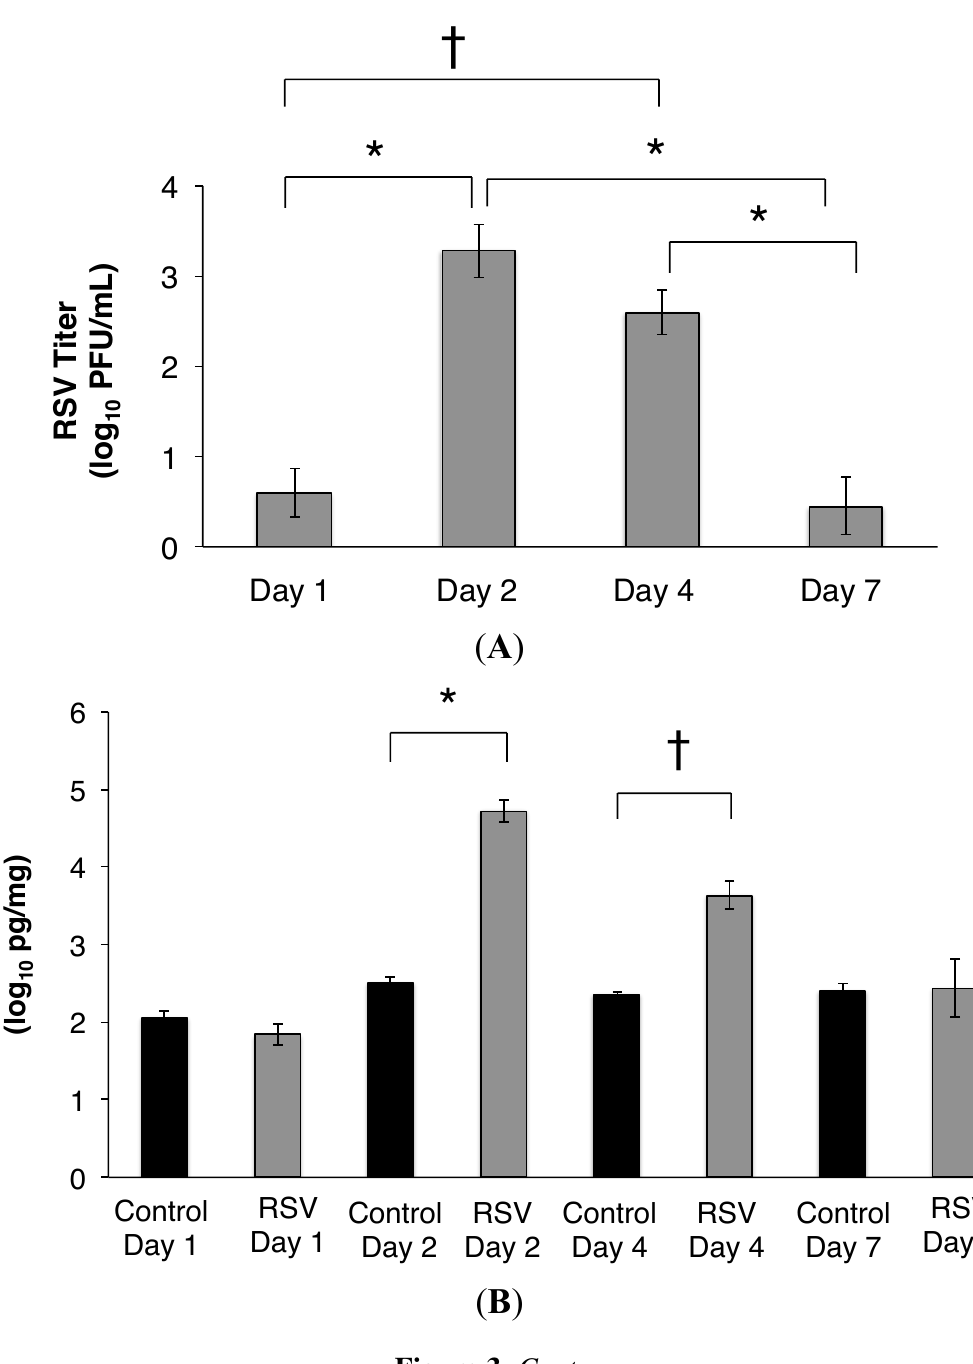
Figure 3. Cont Figure 3. Cont .